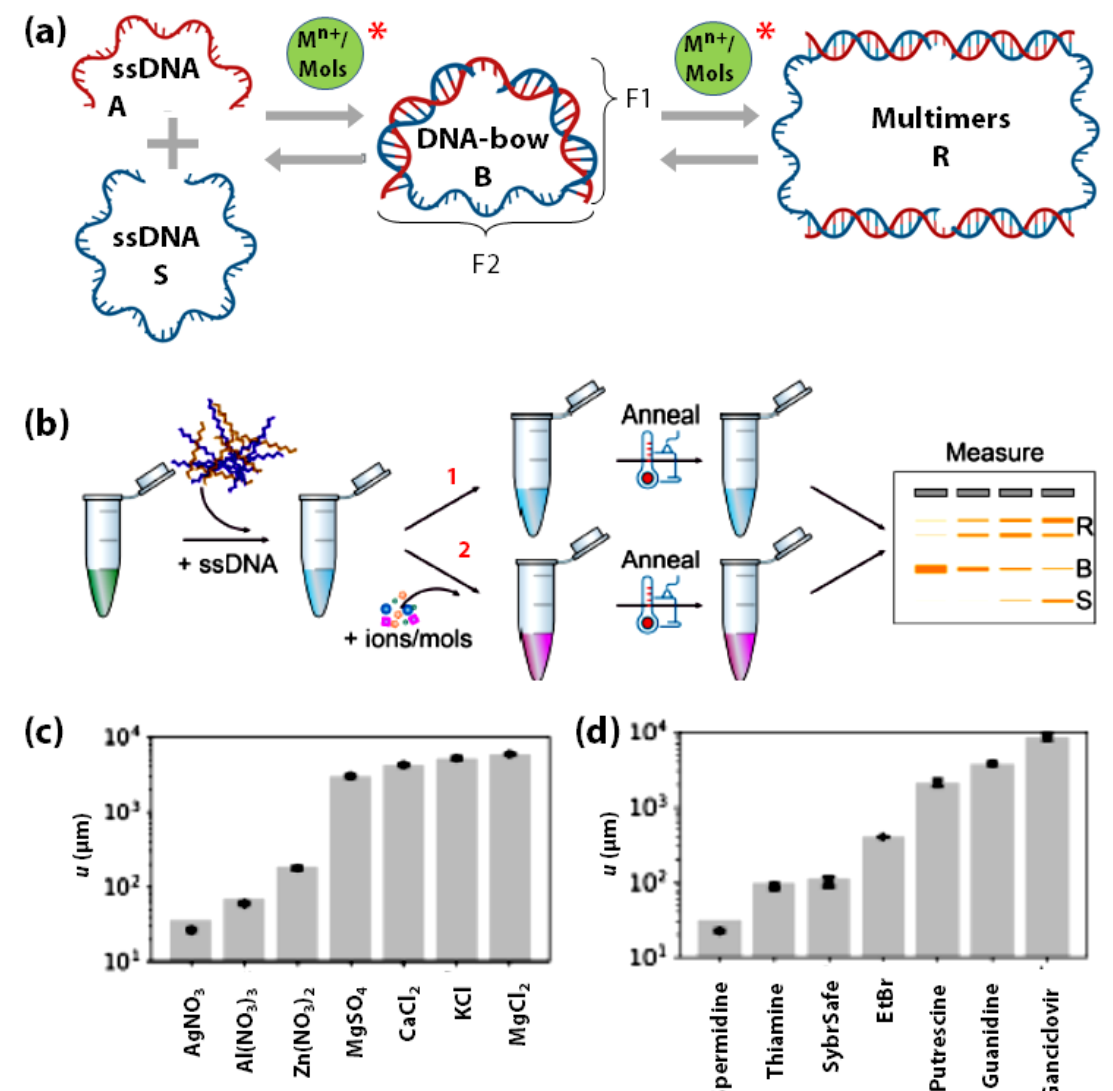
Figure 5. Schematic of ( a ) the constitution of DNA-bows from single-stranded DNA, and the perturbation (depicted by *) of the equilibrium between ss-DNA, DNA-bows, and multimers due to their interaction with metal ions (M n+ ) or small organic molecules (Mols), ( b ) the procedure followed for sensing DNA-metal ion/small molecule interaction via gel electrophoresis, where ‘1’ indicates the negative control with no Mn+/’Mols’ added while ‘2’ depicts the actual experiment with different concentrations of M n+ /’Mols’ added. Fitted u-values for quantifying the strength of DNA interactions with ( c ) metal ion salts and ( d ) small organic molecules. ( b , c ) are adapted with permission from [18]. Copyright 2020, by the authors.